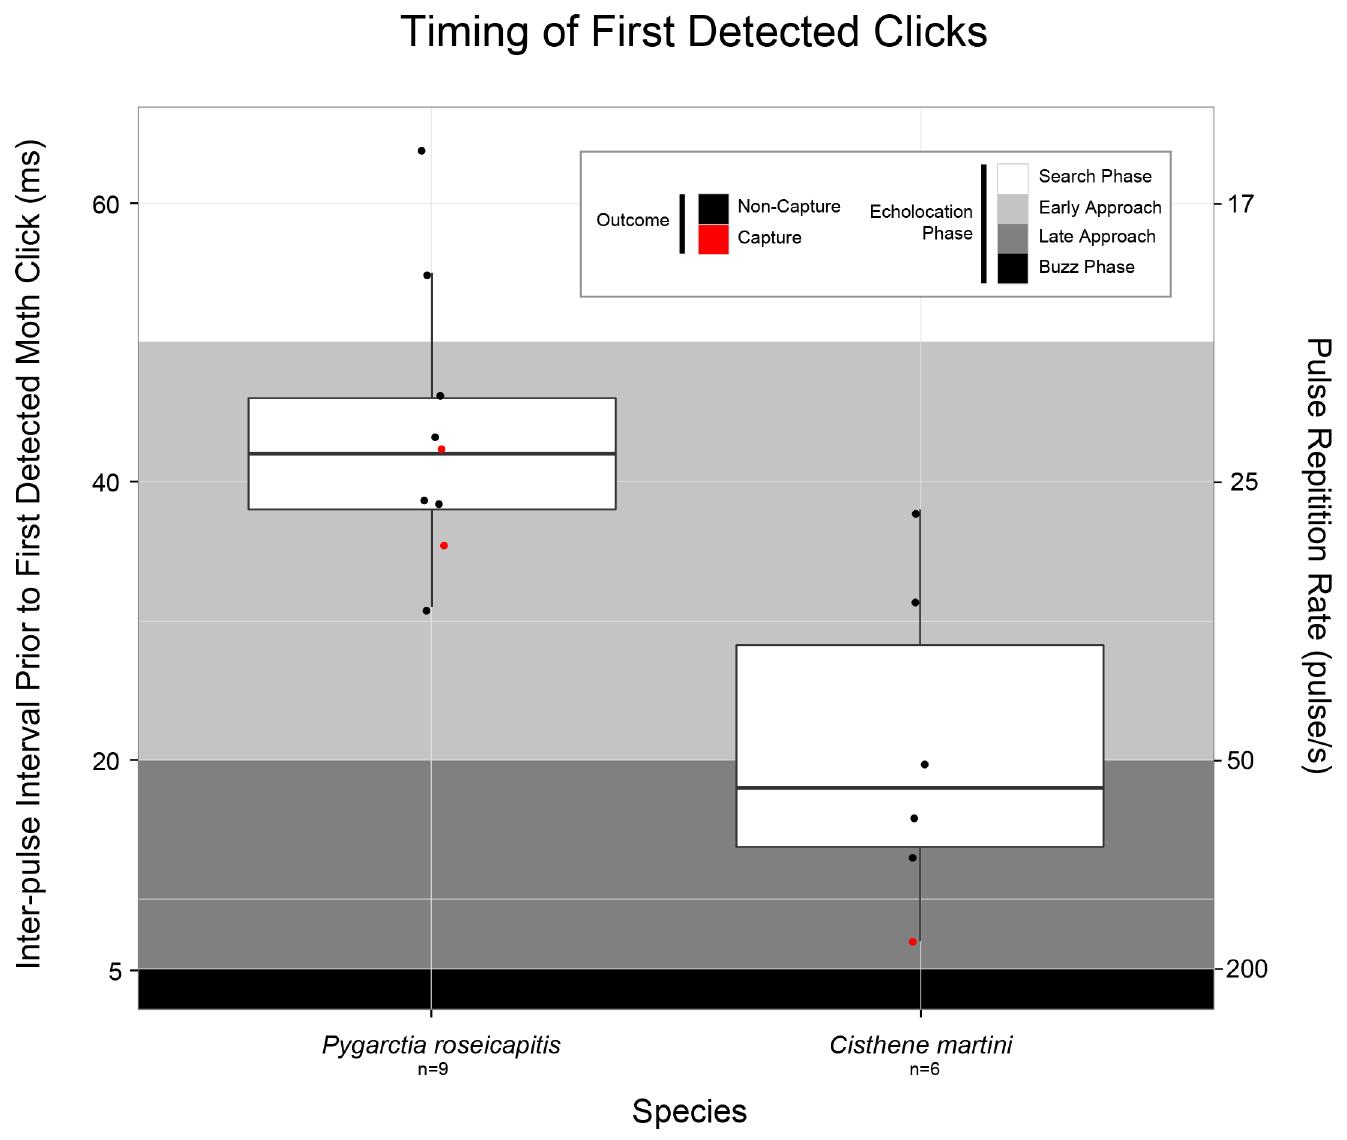
Fig 3. Inter-pulse interval (IPI) between the two bat calls immediately preceding the first detected moth clicks for “ Tymbaled ” (T+ and S groups), sound-producing Pygarctia roseicapitis and Cisthene martini . Box plot upper and lower hinges represent the 25 th and 75 th percentiles of their respective distributions. The 50 th percentile (median) is shown as a thicker black line between hinges. Tukey-style whiskers extend from each hinge to the most extreme value within 1.5 * IQR (inter-quartile range). Actual data from which the box plots are constructed are displayed as points jittered along the midline of their respective box plot. Any data points beyond the whiskers are outliers. “ Non-Capture ” outcomes are colored black and “ Capture ” outcomes are colored red. Bat attack phases and their corresponding range of IPI ’ s are indicated as: Search Phase (white), Early Approach (light grey), Late Approach (dark grey), and Buzz (black). The right y-axis are the values of pulse repetition rate (pulse * sec -1 ) corresponding to the values of IPI.